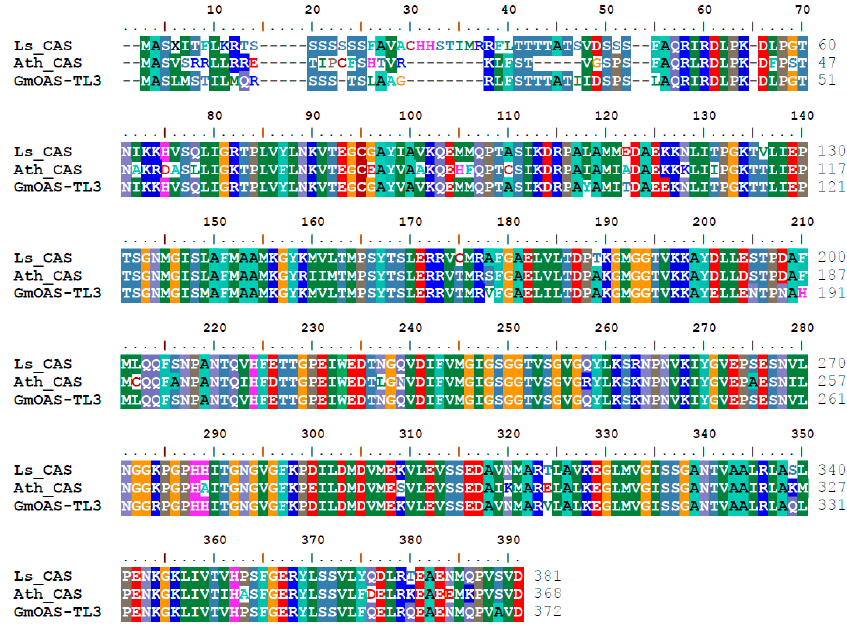
Figure 3. Amino acid sequence alignment of CAS. Protein sequences of grass pea (LsCAS), Arabidopsis (AthCAS) and soybean (GmOAS-TL3) were aligned using DNAMAN program version 8.0 (Lynnon LLC., CA 94583, USA).